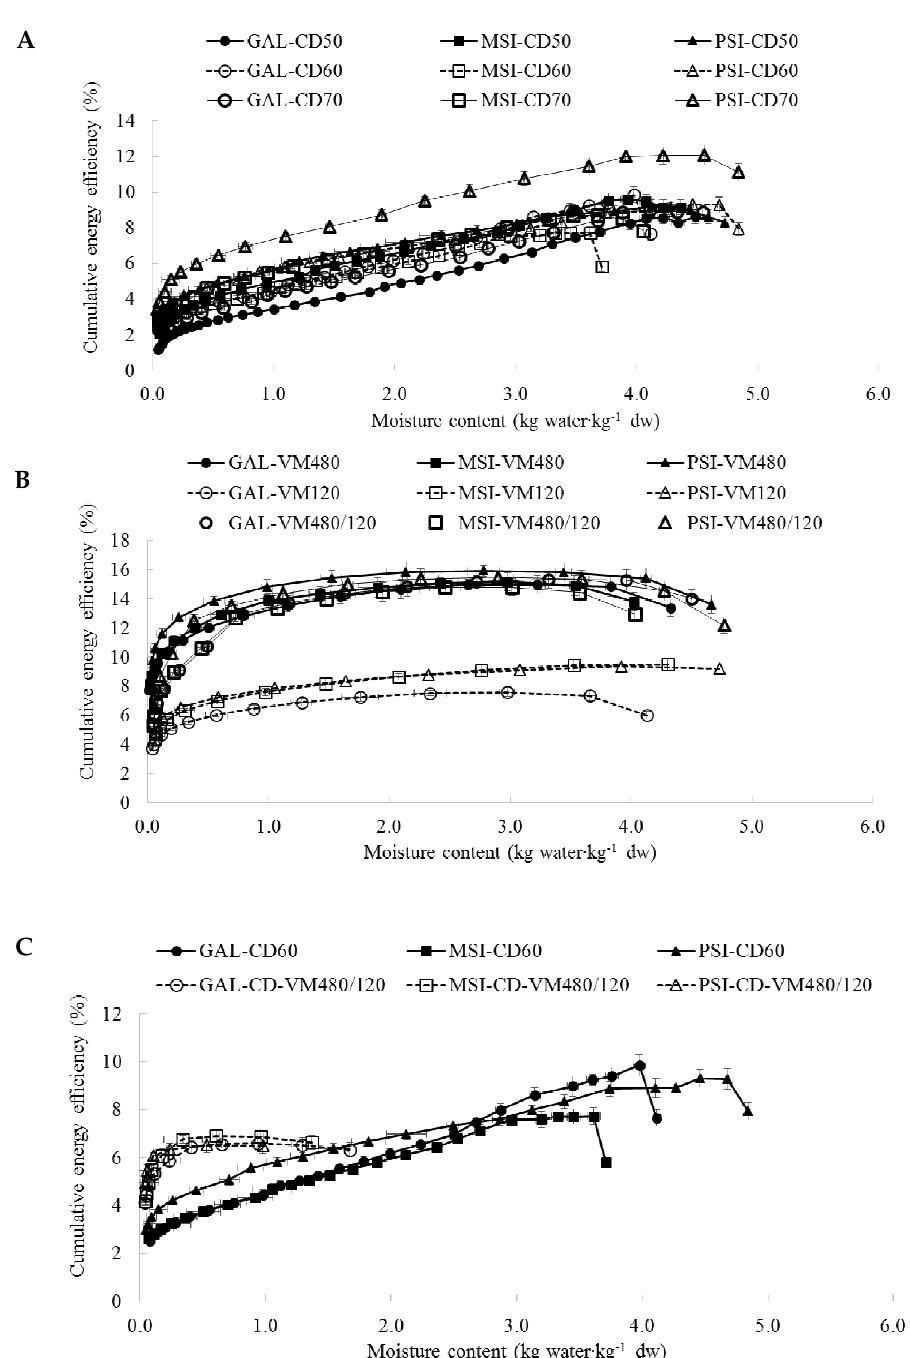
Figure 5. ( A ) Cumulative energy efficiency during CD of jujube fruits. ( B ) Cumulative energy efficiency during VMD of jujube fruits. ( C ) Cumulative energy efficiency during CD 60 °C and CD ‐ VMD (60 °C 480/120W) of jujube fruits.